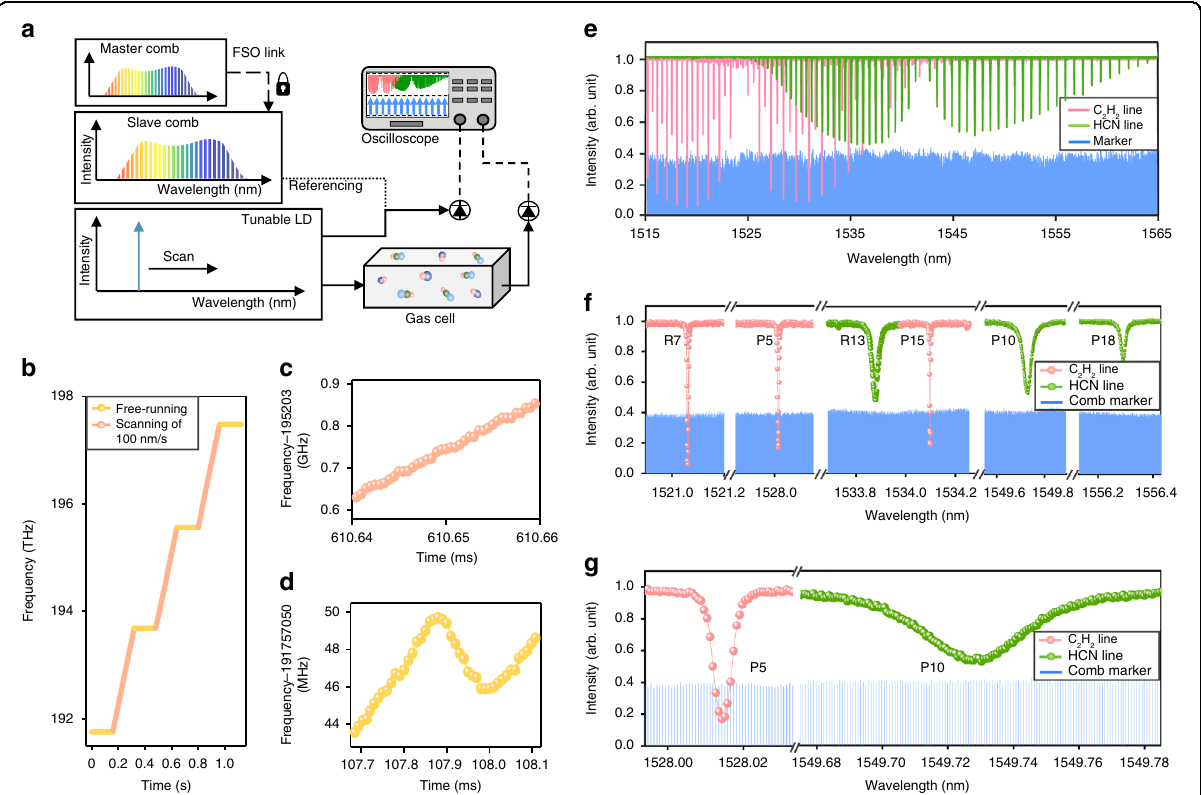
Fig. 3 Molecular absorption spectroscopy using the slave comb. a System con fi guration to calibrate a tunable laser diode (LD) scanning molecular absorption spectra. b Optical frequency scanning from 191.7 THz to 197.7 THz with a tuning speed of 100 nm s – 1 . c Scanning state with frequency calibration. d Free-running state. e Molecular absorption spectra from 12 C 2 H 2 and H 13 C 14 N gas cells with calibration to the slave comb. f R7, P5, and P15 lines of 12 C 2 H 2 and R13, P10, and P18 lines of H 13 C 14 N gas cells. Absorption peaks and comb-referenced markers extracted in steps of 100 MHz. g Expanded views of P5 line of 12 C 2 H 2 , P10 line of H 13 C 14 N, and comb